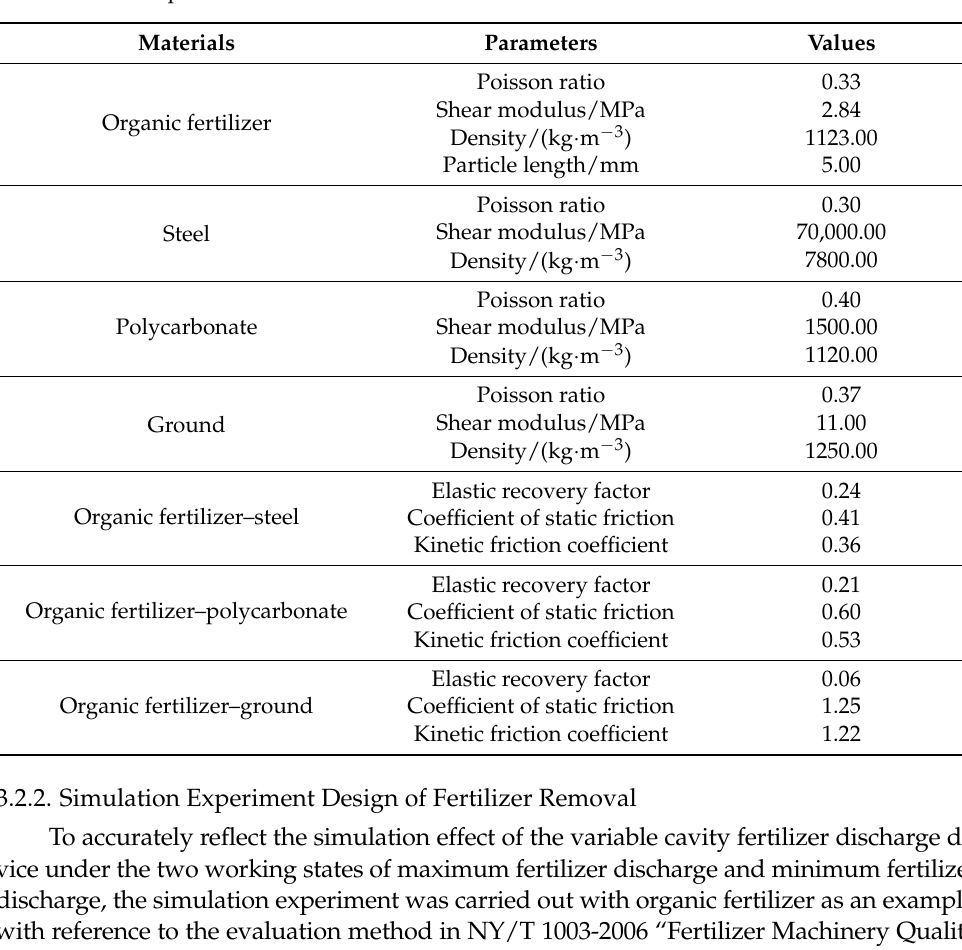
Table 1. Variable parameter.